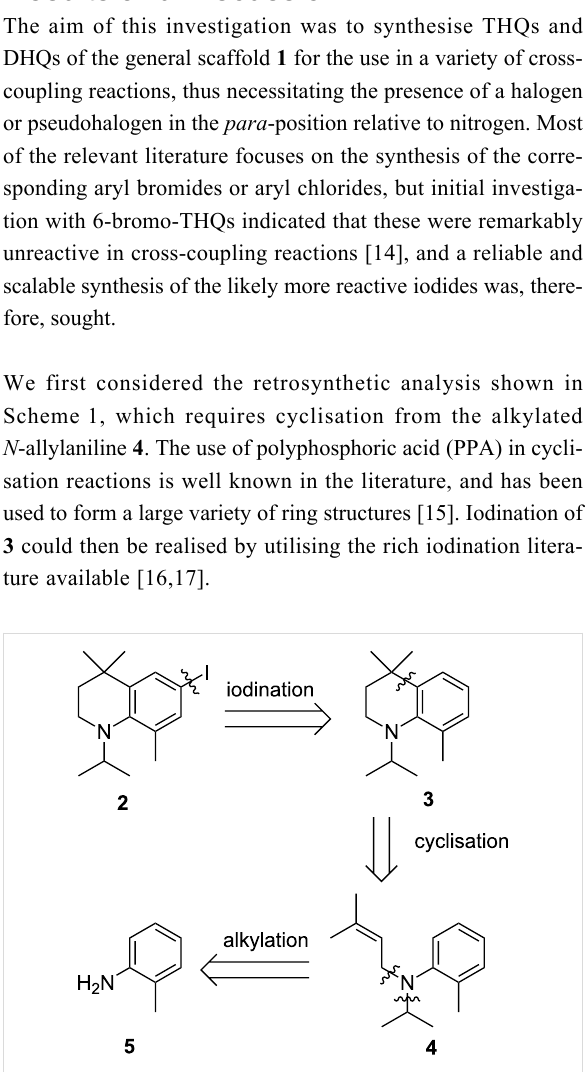
Figure 1: Tetrahydroquinoline (THQ) and dihydroquinoline (DHQ) scaffolds to be synthesised.